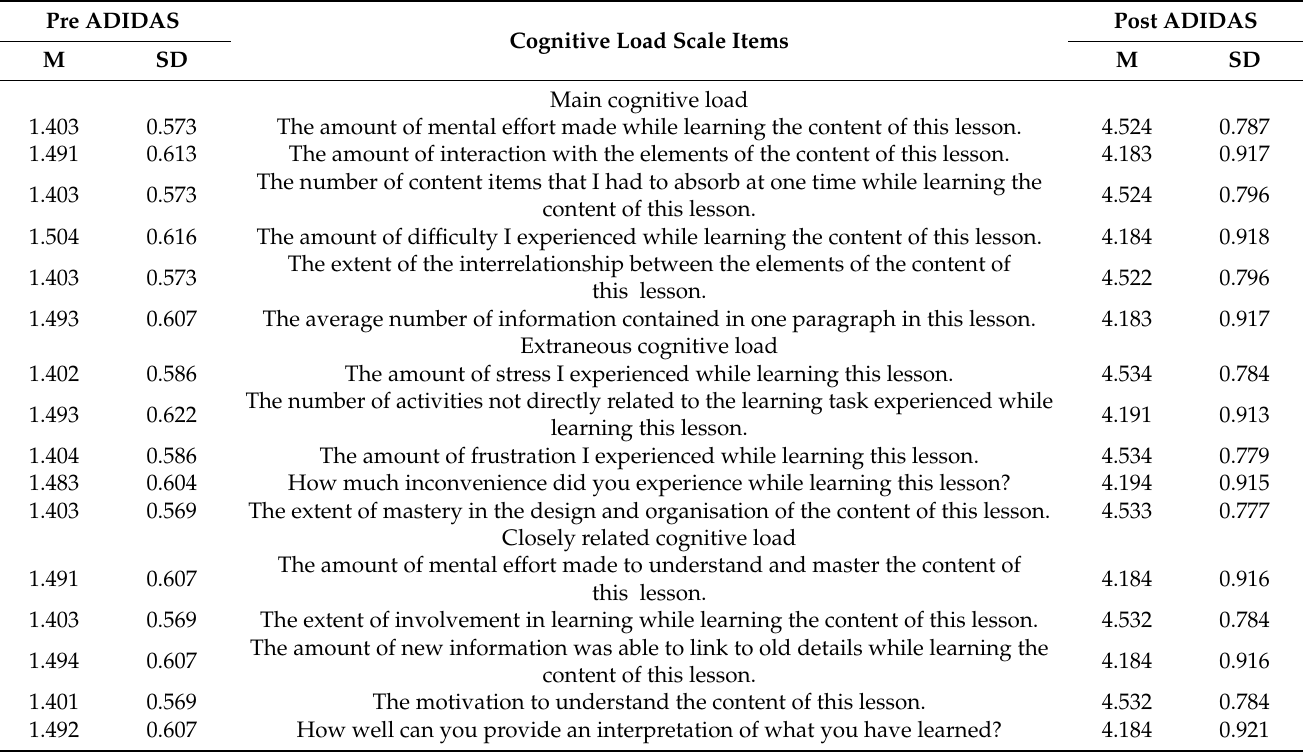
Table 3. Descriptive statistics of students’ cognitive load pre- and post-ADIDAS model.